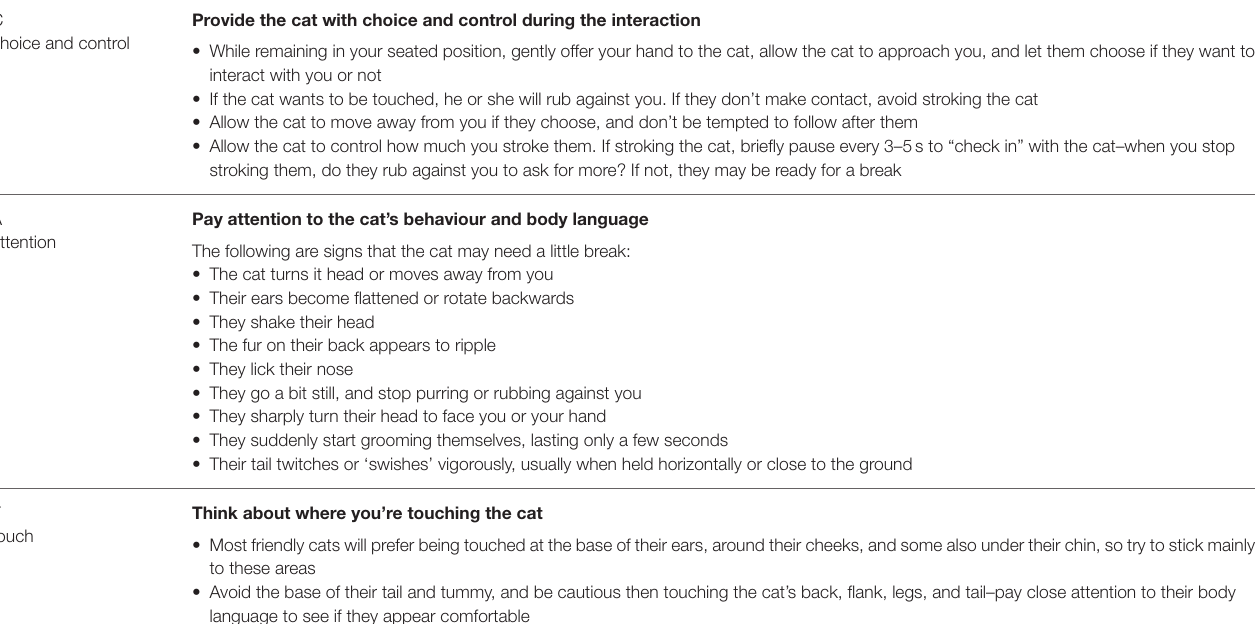
TABLE 1 | A summary of the key principles of the “CAT” interaction guidelines explained to participants during the training